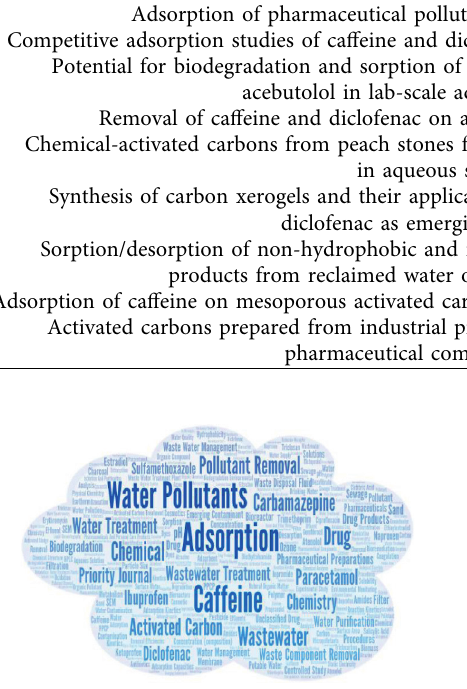
Figure 3: Word cloud view of the most frequently used keywords for caffeine adsorption.